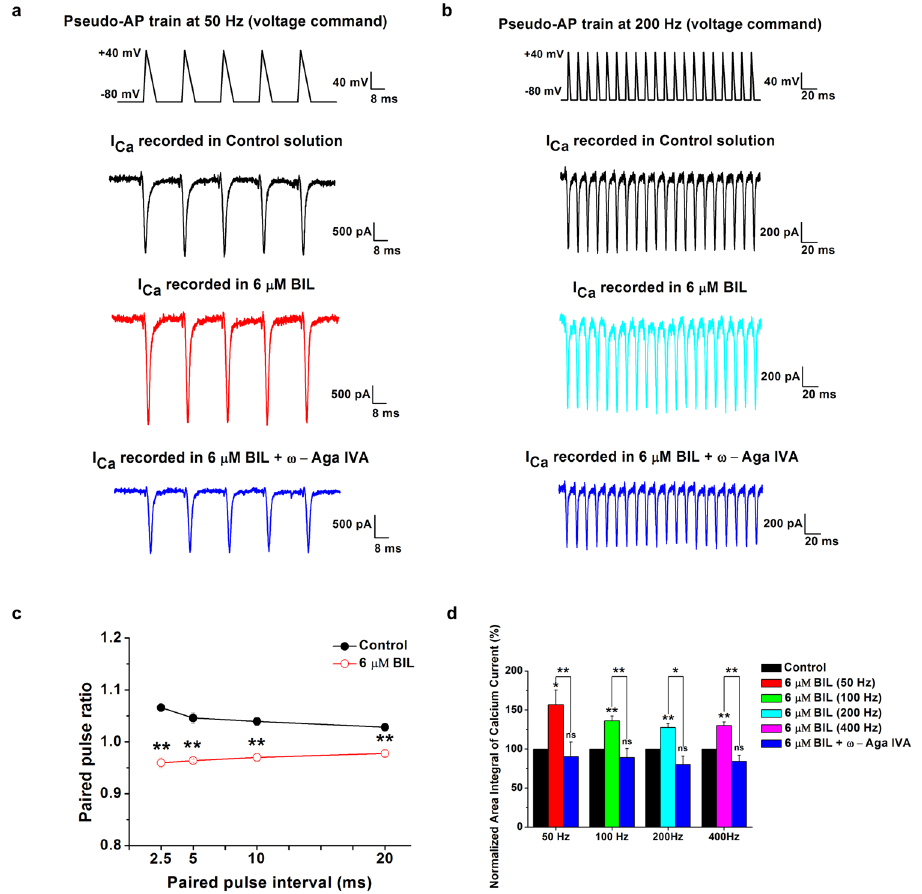
Figure 8. Bilirubin-induced enhancement in Ca 2 + integrals through P/Q-type VGCC by pseudo AP trains. Example recordings of calcium currents in response to 50 Hz and 200 Hz AP like voltage ramps (AP waveform: − 80 to + 40 mV, rise time: 2 ms, decay time: 6 ms; Top traces in a and b ) in the presence of Ca 2 + buffer EGTA at low concentration (0.5 mM) in pipette solution. The control solution was applied for 5 min, followed by the bath application of 6 μ M bilirubin for 6 min and 500 nM ω - Agatoxin IVA for another 5 min. The paired pulse ratio of the amplitude of the second and the first spike at 50 Hz, 100 Hz, 200 Hz and 400 Hz in the absence ( c , black circle) and presence of 6 μ M bilirubin ( c , red circle) described the difference in the facilitation of VGCCs. The area integral of calcium current evoked by AP trains increased at 50 Hz ( d , red bar), 100 Hz ( d , green bar), 200 Hz ( d , cyan bar) and 400 Hz ( d , magenta bar), and was all attenuated after applying ω - Agatoxin IVA ( d , blue bars). * P < 0.05, ** P < 0.01 , ns, not significant, one-way ANOVA followed by Bonferroni post hoc